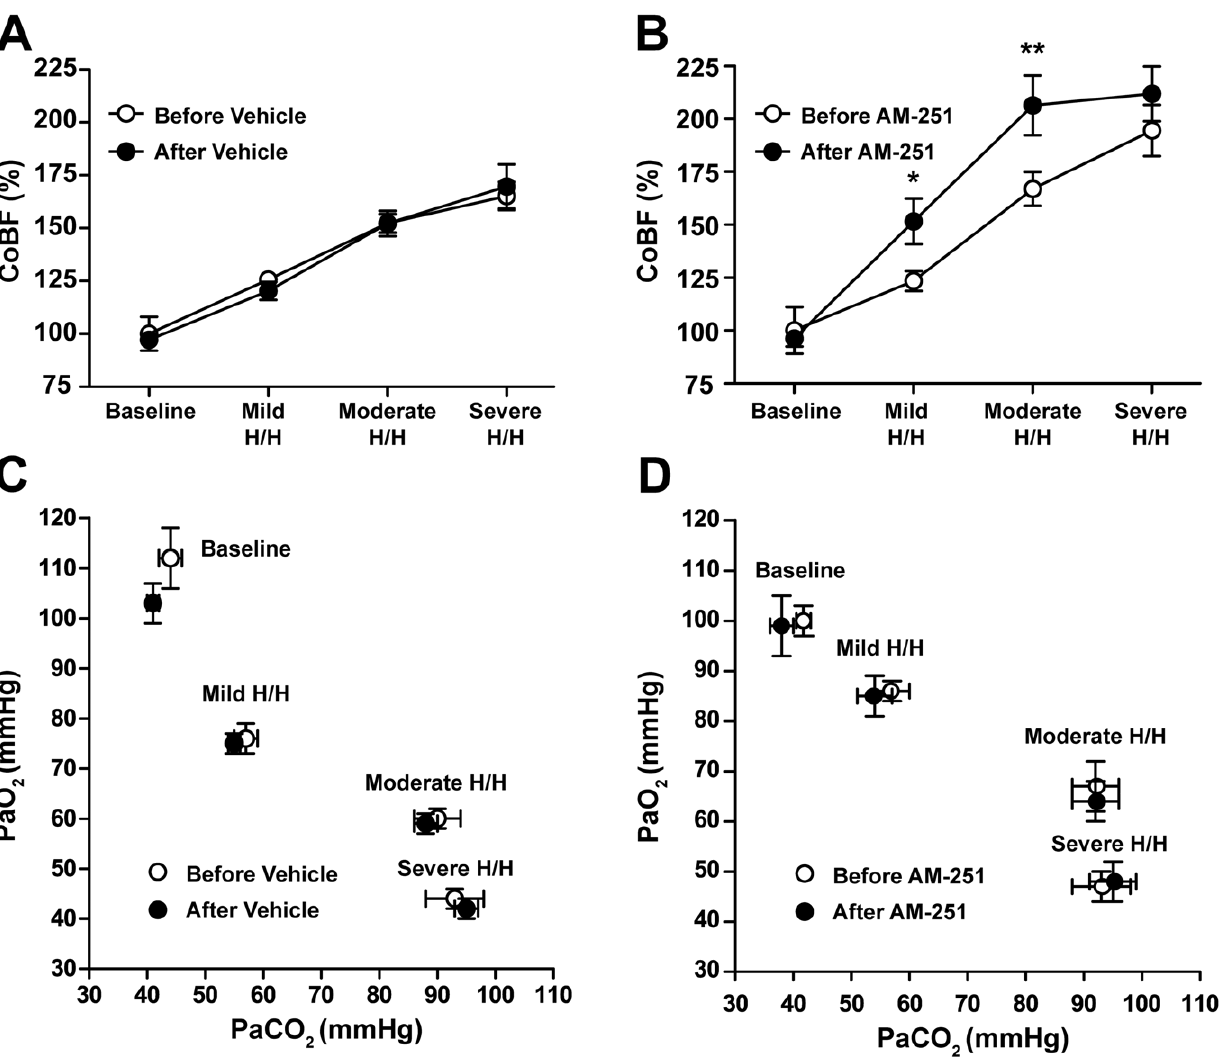
Figure 5. Cerebrocortical blood flow and arterial blood gas tensions during stepwise hypoxia/hypercapnia. Cerebrocortical blood flow N (A and B, expressed as percentage of baseline levels) and arterial blood-gas tensions (C and D) are shown before (Baseline) and during mild, moderate ) intravenous injection of 10 mg kg 2 1 AM-251 or its vehicle. Values are mean 6 SEM, and severe hypoxia/hypercapnia before ( # ) and after ( *P , 0.05, **P , 0.01 versus ‘‘Before AM-251’’, n=4–12.